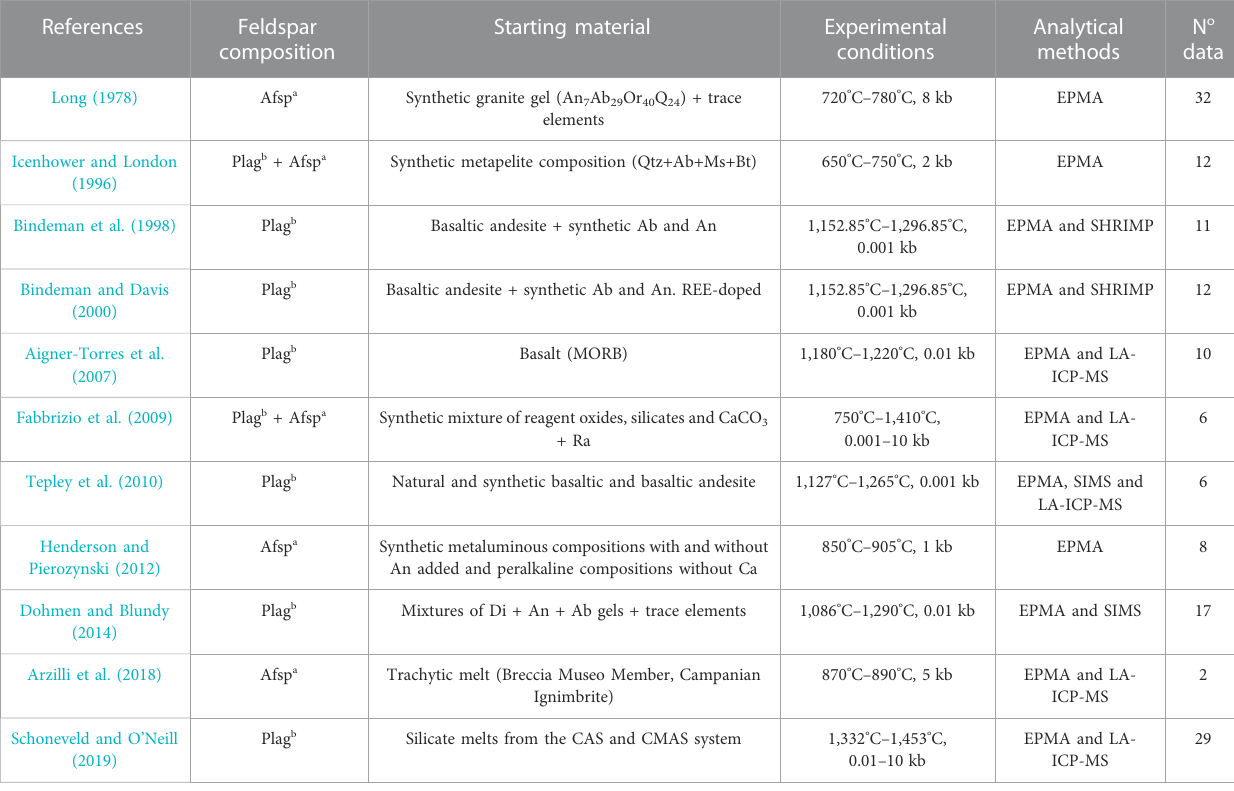
TABLE 1 Summary of experimental studies on the plagioclase-feldspar/melt element partitioning used in the multiple regression analysis in this study. a Alkali feldspar, b plagioclase. Mineral abbreviations after Whitney and Evans